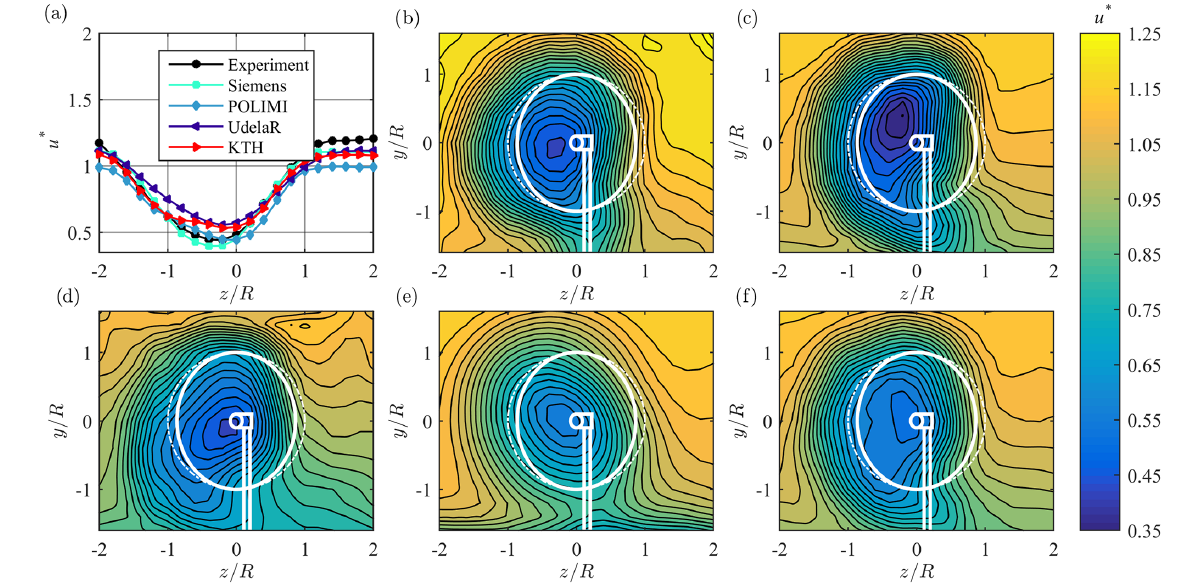
Figure 11. (a) Line plot at hub height and (b–f) contour plots for normalized streamwise mean velocity u ∗ in the wake 3 D behind down- stream turbine T2, from (b) experiments, (c) Siemens, (d) POLIMI, (e) UdelaR, and (f) KTH. The white lines represent the turbine rotor, nacelle, and tower; solid lines γ = 30 ◦ ; dashed lines γ = 0 ◦ .